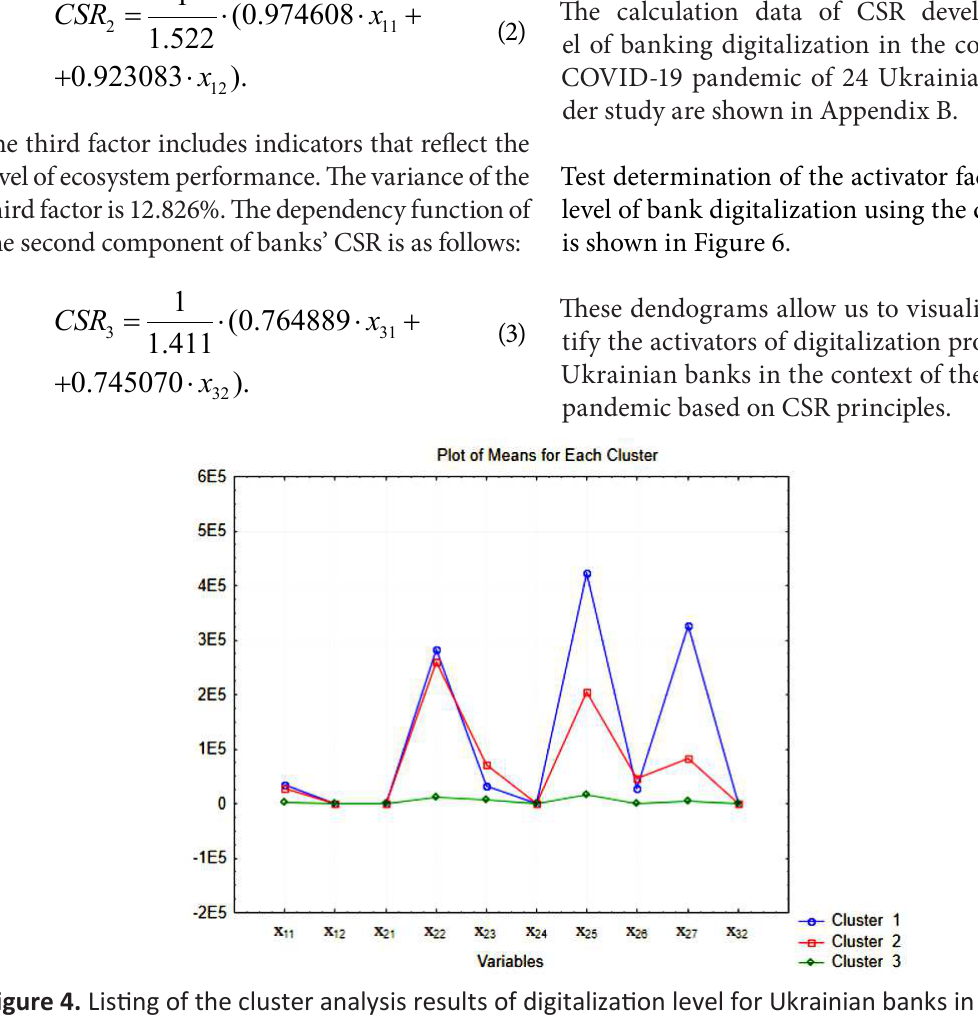
Figure 4. Listing of the cluster analysis results of digitalization level for Ukrainian banks in the